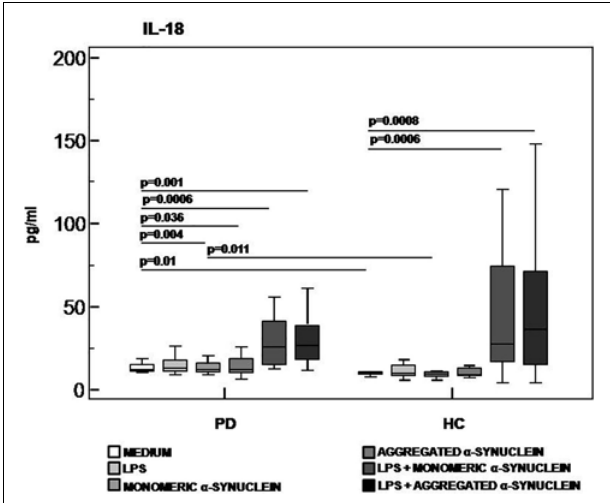
FIGURE 4 | IL-18 inflammasome effector cytokine production in LPS-primed and monomeric or aggregated α -synuclein–stimulated PBMCs of PD and HC subjects. PBMCs of 15 Parkinson disease (PD) patients and 15 healthy controls (HC) were stimulated as follows: unstimulated, LPS-stimulated, monomeric α -synuclein–stimulated, aggregated α -synuclein–stimulated, LPS-primed and monomeric α -synuclein–stimulated, or LPS-primed and aggregated α -synuclein stimulate. IL-1 β was quantified in supernatants by enzyme-linked immunosorbent assay. Summary results are shown in the bar graphs. The boxes stretch from the 25th to the 75th percentile; the line across the boxes indicates the median values; the lines stretching from the boxes indicate extreme